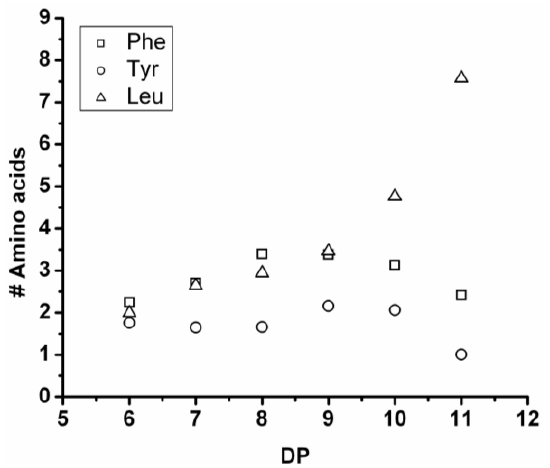
Figure 23. Average number of amino acids in Oligo(Phe-co-Tyr-co-Leu) for every observed